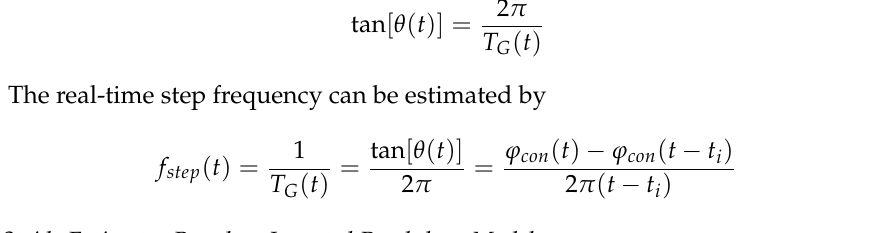
1𝐼𝑃 Figure 3. Inverted pendulum model during Figure 3. Inverted pendulum model during walking. 𝜃